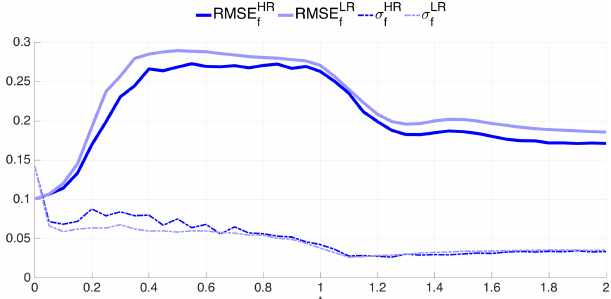
Figure 7. Time evolution of the forecast RMSE (solid line) and spread ( σ ; dashed line) of DA-free ensemble run using BGM. Dark and light blue lines represent the HR and LR,